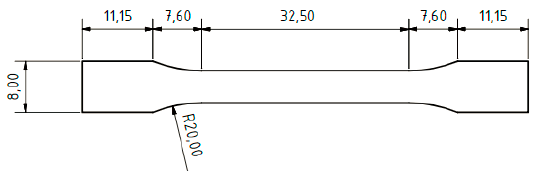
Figure 6. Specimen geometry used for tensile testing [mm].